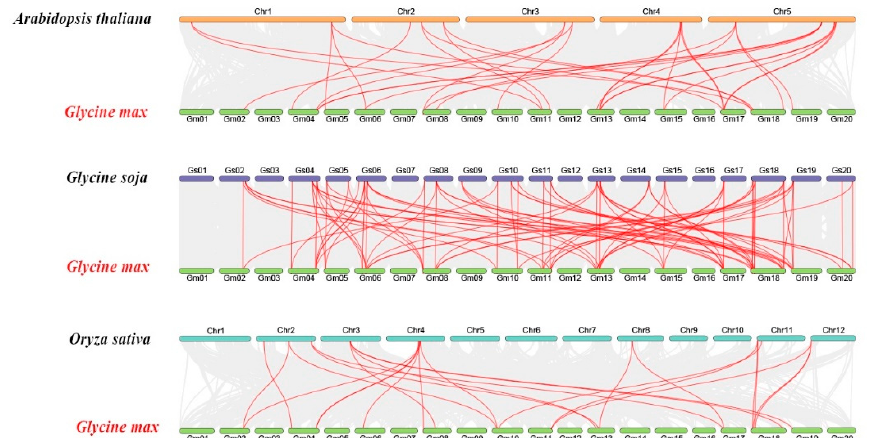
Figure 5. Synteny analyses of the SMXL genes between soybean and three representative species. The collinear blocks within soybean and other specie genomes were displayed by the gray lines. The syntenic SMXL gene pairs between soybean and other species were highlighted with the red lines.